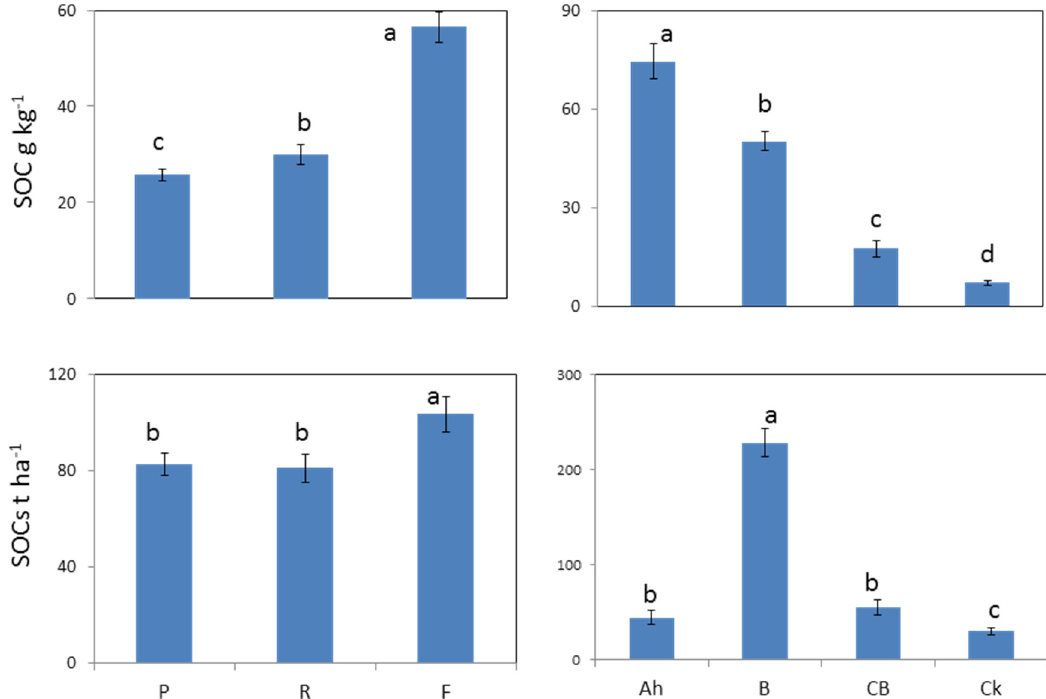
Figure 2. Soil organic carbon concentration and stock per land use (forest, F; reforestation, R; prairie, P) and soil depth. Data followed by the same letter are not statistically different from each other (Student’s test, p = 0.05).